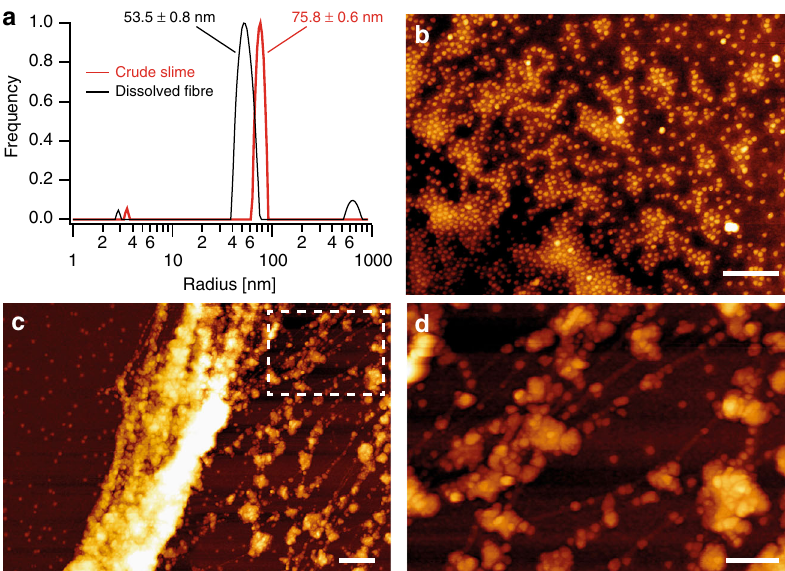
Fig. 2 Nanoglobular structure of slime of Euperipatoides rowelli . a DLS measurements indicating monodisperse nanoscopic particles in crude slime and dissolved fi bre solutions. b AFM imaging of a 1:100 diluted slime solution physisorbed on a mica surface ( scale bar = 1 µ m). c AFM image of 1:100 diluted slime shaken before physisorption on mica ( scale bar = 2 µ m). d Zoomed area indicated by dashed box in c ( scale bar = 1 µ